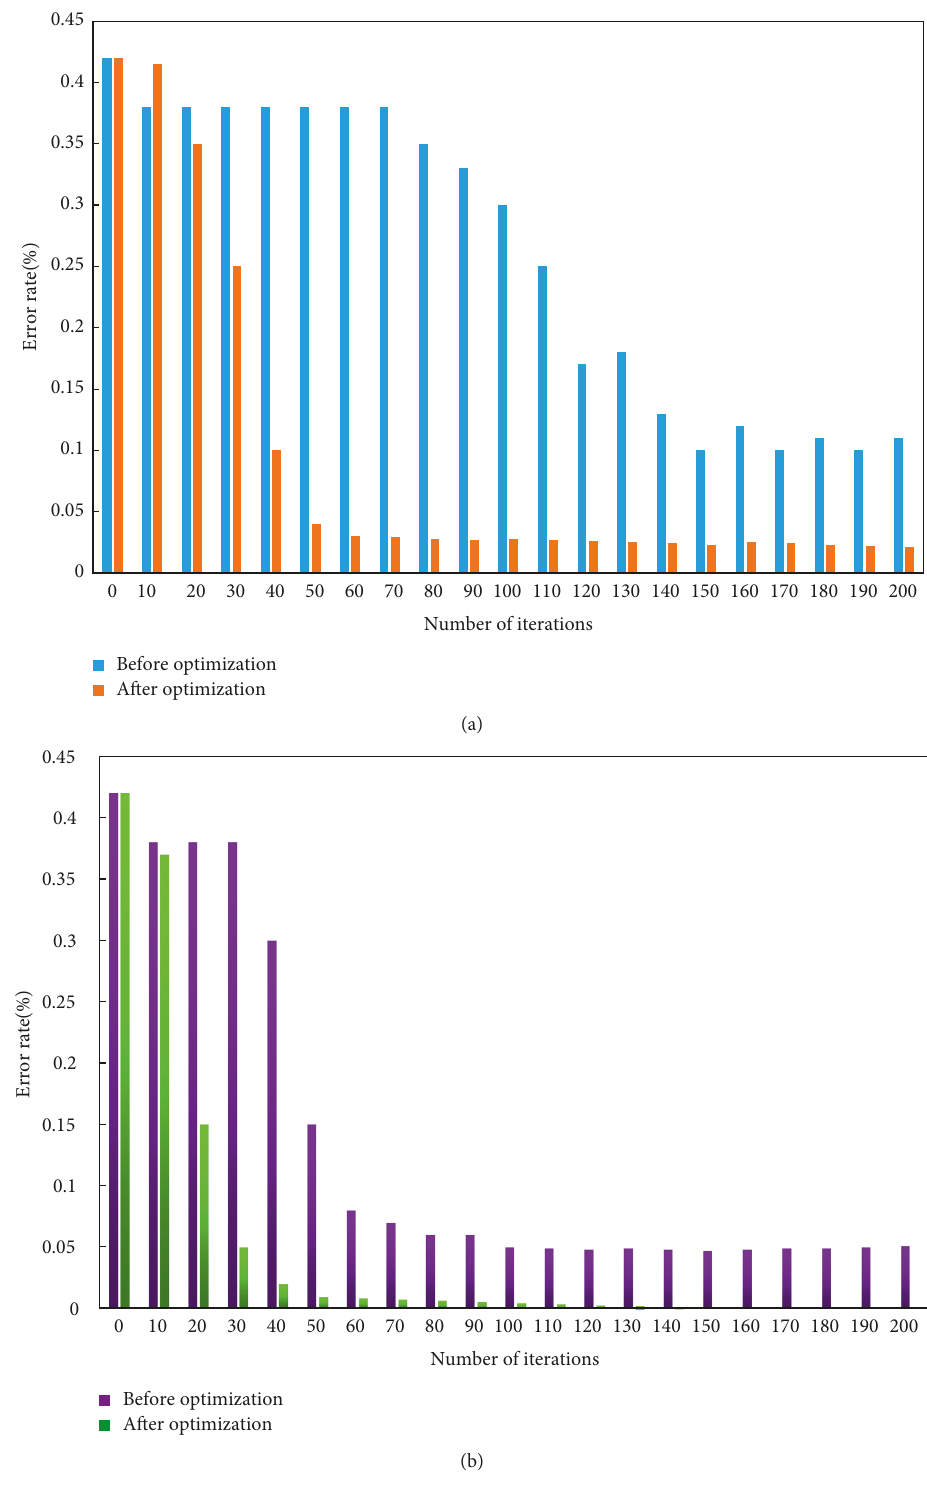
Figure 8: Comparison of test results of small/large batch samples before and after optimization. (a) Comparison of test results of small batch samples before and after optimization. (b) Comparison of test results of large batches of samples before and after